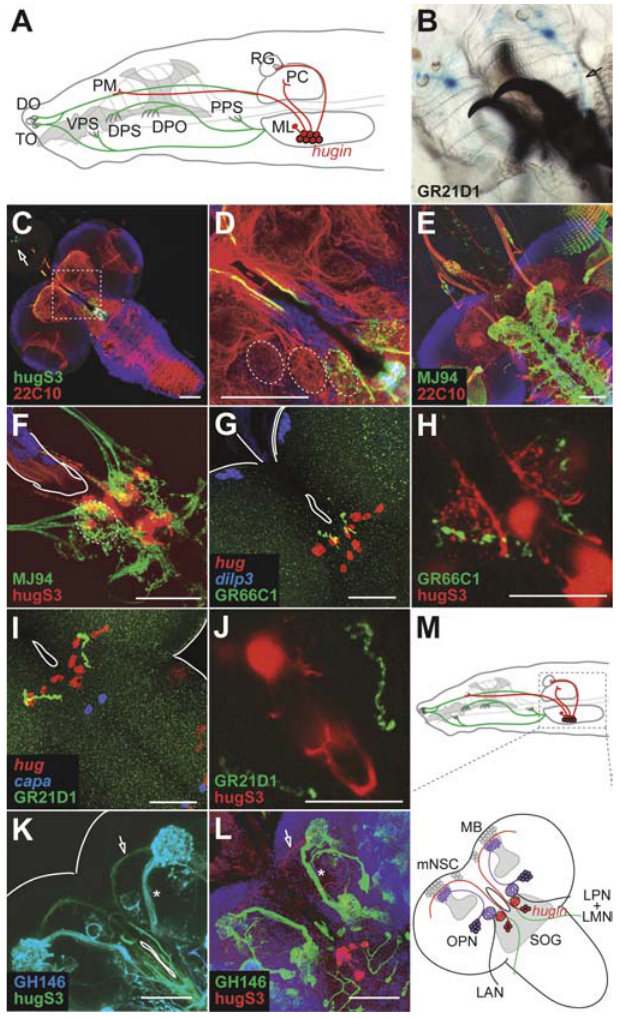
Figure 3. hug Neurons Receive Gustatory